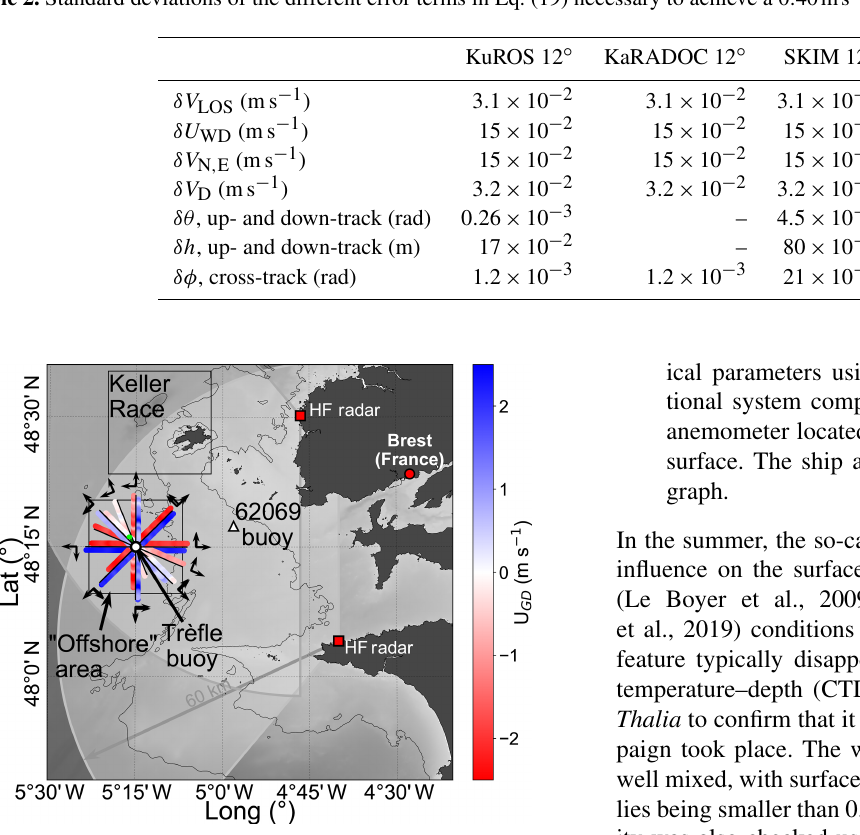
Figure 6. Location of the measurement campaign and in situ assets, including a map of the KaRADOC measurements of the geophysi- cal Doppler velocity U GD acquired on 22 November 2018.